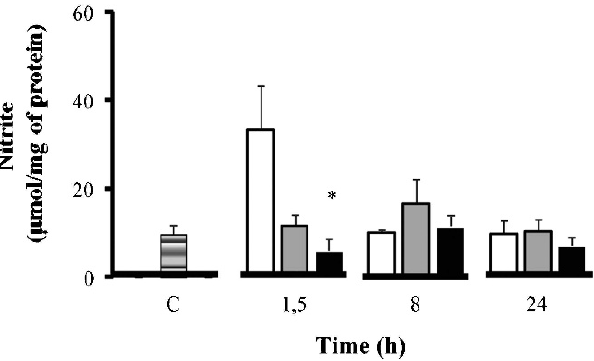
Figure4- Oxidativestress- Nitriteconcentrations( m mol/mgofprotein) in the intestine. Wistar male rats were challenged with LPS (LPS - white) and treated with SH (LPS + H - black) and SS (LPS + S - gray). The levels of nitrite were measured in the intestine. * p , 0.05 vs. LPS in the same period. n=10 mice per group. Data are means ¡ SEM.